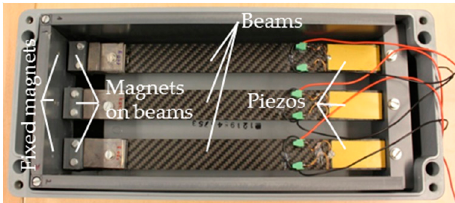
Figure 7. Three beams with PZT piezos and at their free ends repellent magnets.